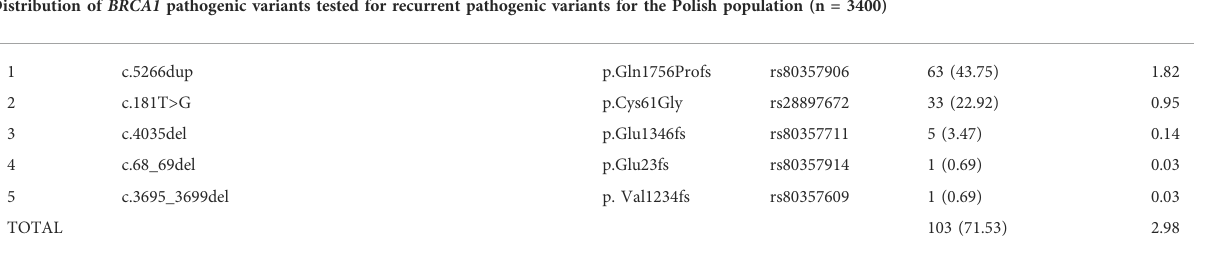
% of cases (% of all detected variants, n = 144)